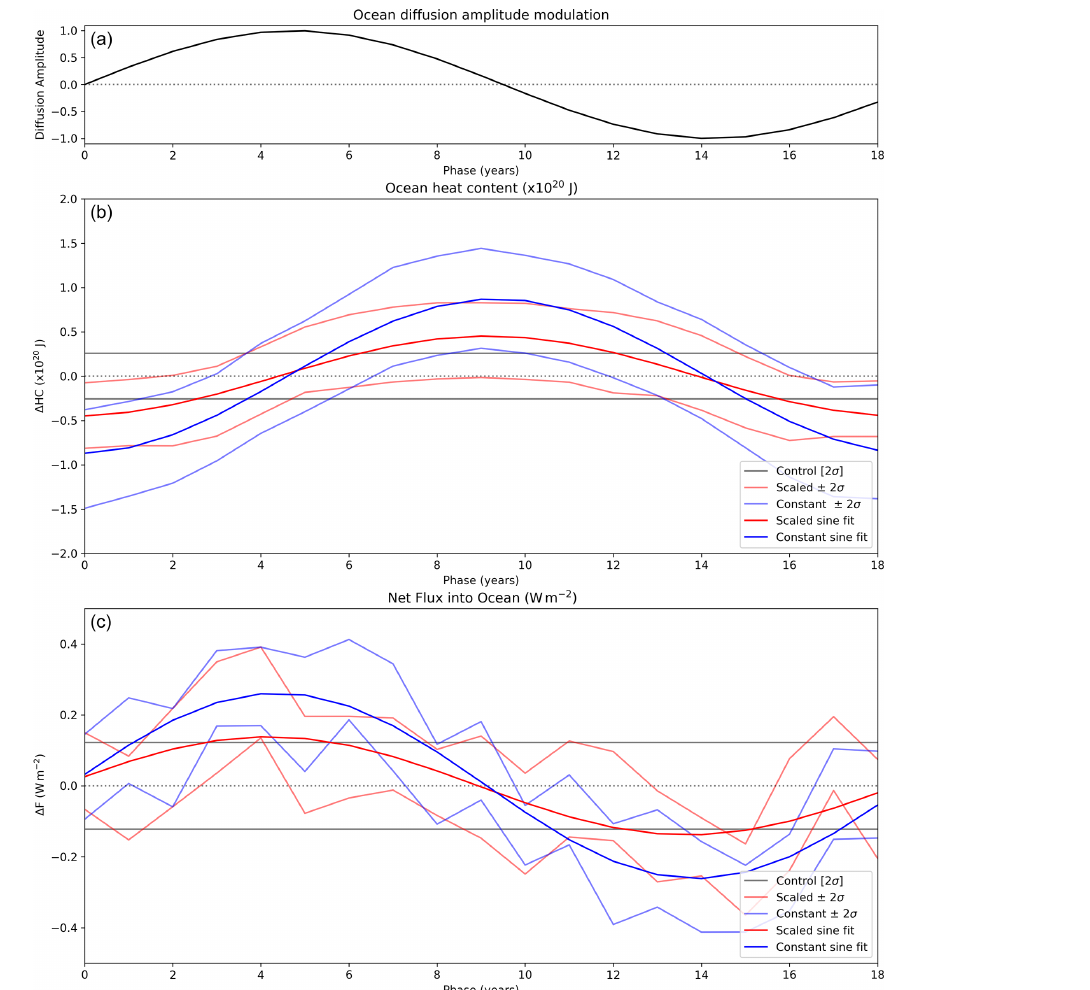
Figure 3. (a) Variation in time of the modulation of diffusion T ( t ) (see Eq. 1). (b) Globally averaged ocean heat content anomaly (10 22 J) vs. tidal modulation phase. The mean ± 2 standard errors are shown for the constant run in thin blue and for the scaled run in thin red; sinusoidal best fit curves of global temperature anomalies versus phase are shown for the constant run in thick blue and for the scaled run in thick red; the mean ± 2 standard errors of heat content anomaly in the control integration of FORTE2 are shown for reference in black in order to demonstrate the size of the signal compared to internal variability in the control run. (c) As for (b) but for the globally averaged surface ocean heat flux anomaly (Wm − 2 ) vs. tidal modulation